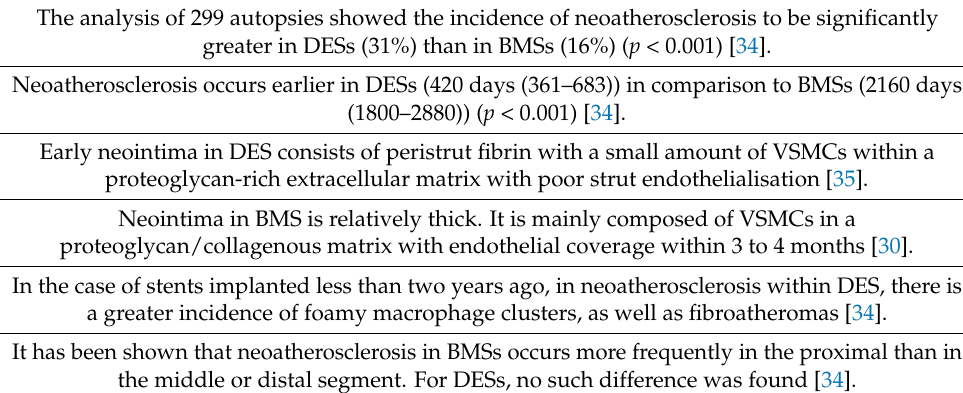
Table 2. Selected differences and similarities between neoatherosclerosis within BMSs and DESs. The analysis of 299 autopsies showed the incidence of neoatherosclerosis to be significantly greater in DESs (31%) than in BMSs (16%) ( p < 0.001) [34].